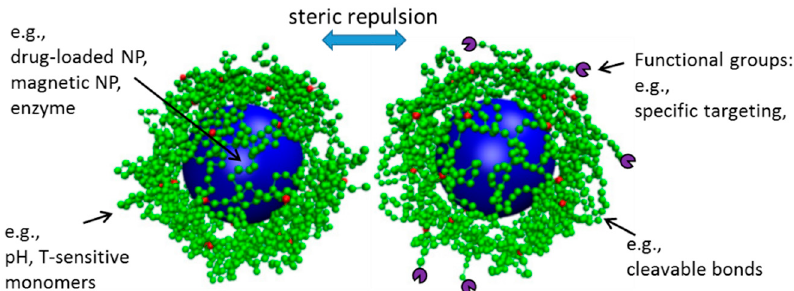
Figure 1. Nanoparticle—nanogel complexes depicting steric repulsions between the adsorbed polymers chains, and possible functionalization of the polymers in the nanogels. Snapshots were adapted from Nicholas Christiansen’s master thesis, August 2018, NTNU.